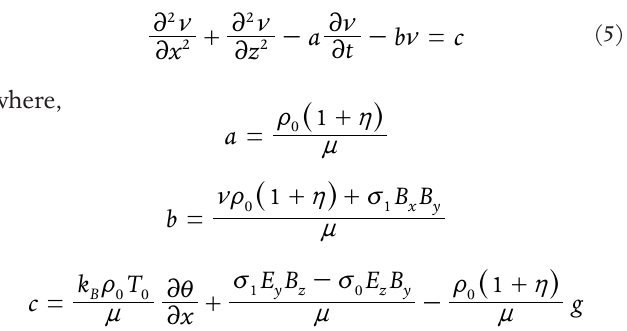
Figure 2. Changes in the heating rates with dimensionless time at an altitude (z) of 180 km. The total heating is the sum of the Joule heating and the viscous heating, which approaches a steady